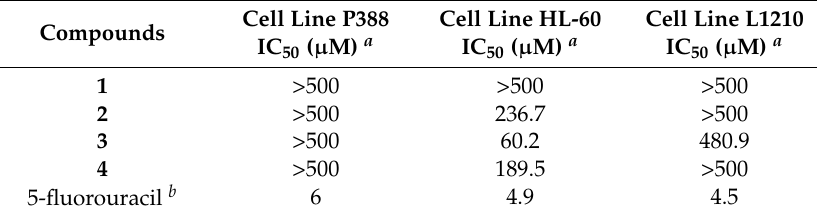
Table 3. Cytotoxicity assay against P388, HL-60, and